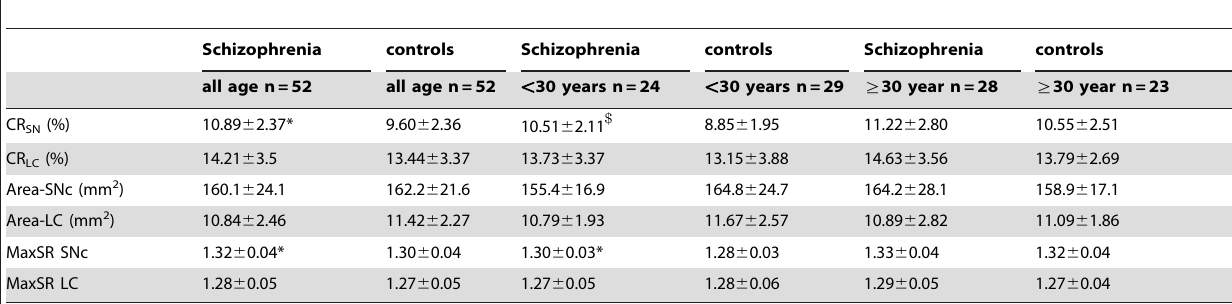
Table 2. Neuromelanin imaging characteristics of patients with schizophrenia and healthy